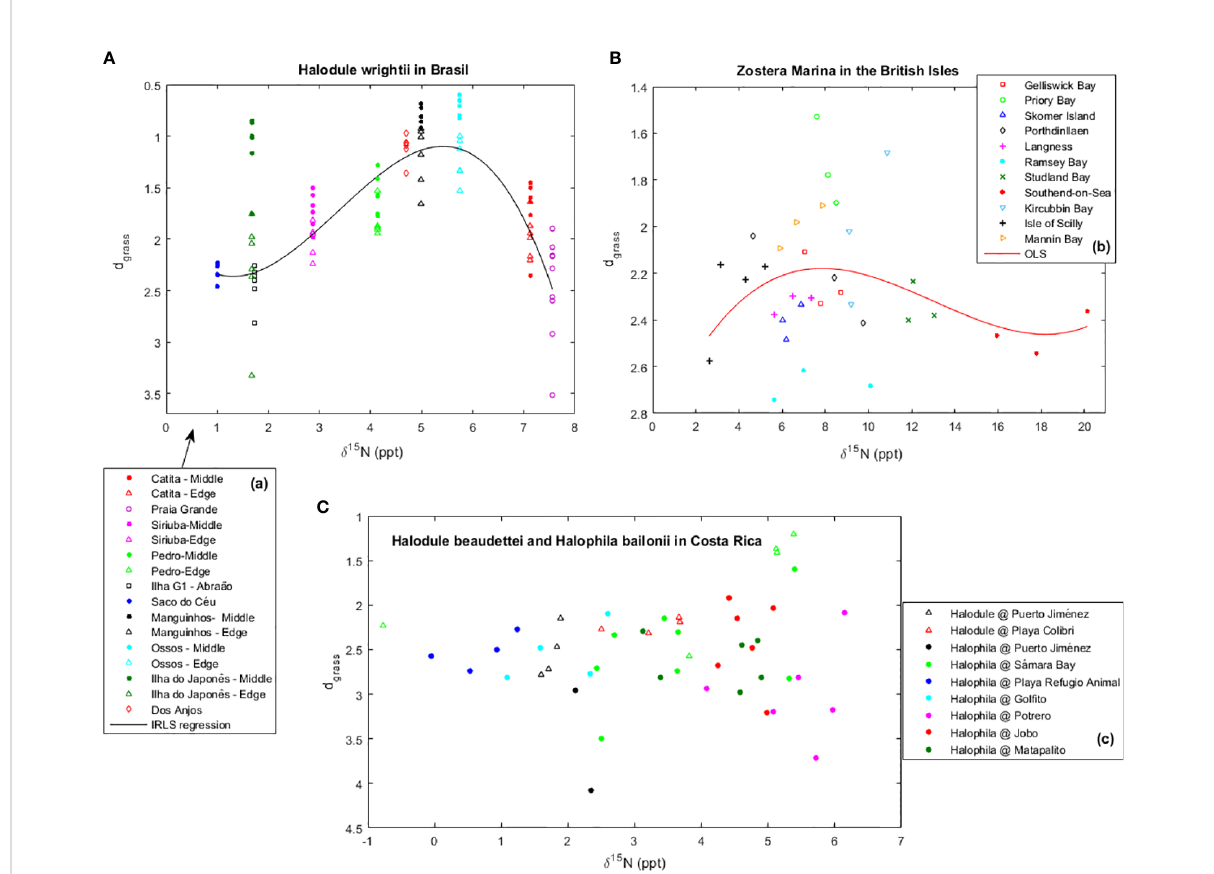
FIGURE 6 Health of (A) Halodule wrightii meadows in Brazil, (B) Zostera marina meadows in the British Isles, and (C) Halodule beaudettei and Halophila baillonii meadows in Costa Rica and their relation with the proportion of the d 15 N isotope to total N in seagrass leaf content. Seagrass health is indicated by their distance (d grass ) to the seagrass IBL (i.e., their ef fi ciency of space occupation). In some locations, samples were taken from both the middle (Middle) and the edge (Edge) of the meadow. Trends fi t by maximum likelihood estimation